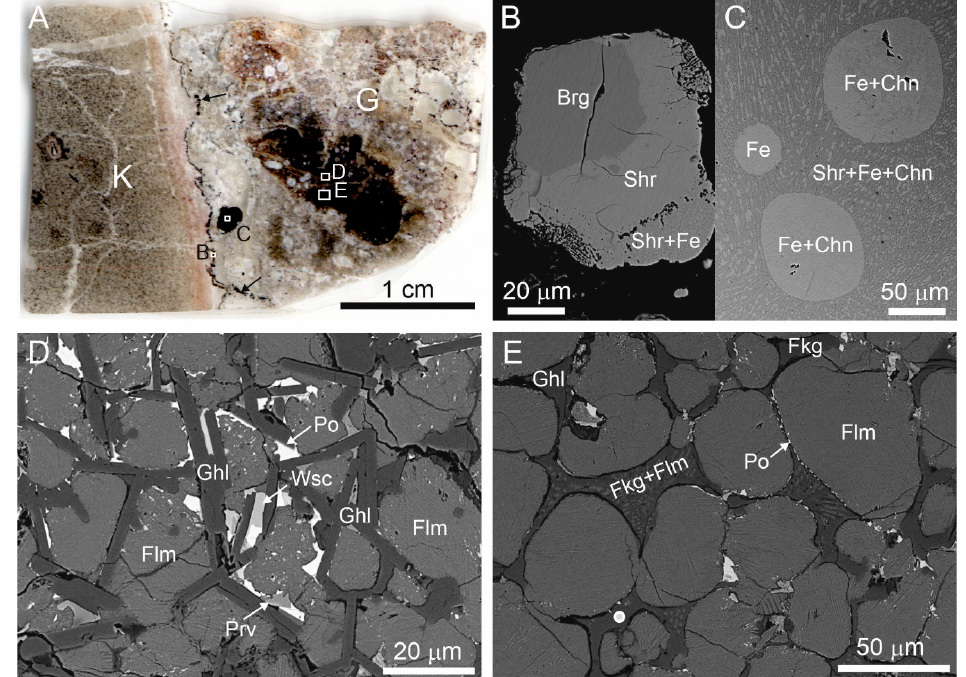
Figure 1. ( A ) Scanned image of thin section. Contact of katoite rock (K) and altered gehlenite-flamite rock (G), including weakly-altered fragment (black). A fine black zone enriched with minerals of the Fe-P-C system (black arrows) is on the rocks contact, these minerals form large oval inclusions in gehlenite rock also. Fragments magnified in Figure 1B–D, E are shown by frames. ( B ) Zonal grain with consequent zones: barringerite, schreibersite, and schreibersite-native iron (Fe) eutectic. ( C ) Fe drop and Fe-cohenite eutectic drops in schreibersite-Fe-cohenite eutectic. ( D ) Unaltered gehlenite-flamite rock with abundant pyrrhotite inclusions and rare inclusions of wüstite and perovskite. ( E ) Flamite-gehlenite rock, which is subjected to repeated partial melting, that is reflected in rounded flamite grains and in the crystallization of xenomorphic gehlenite, fluormayenite (replaced by fluorkyuygenite), and fluormayenite (fluorkyuygenite)-flamite eutectic in intergranular space. The white circle is the point where the Raman spectrum shown in Figure 2A,B was obtained. Brg = barringerite, Chn = cohenite, Fe = native iron, Flm = flamite, Fkg = fluorkyuygenite, Ghl = gehlenite, Po = pyrrhotite, Prv = perovskite, Shr = schreibersite, Wsc =